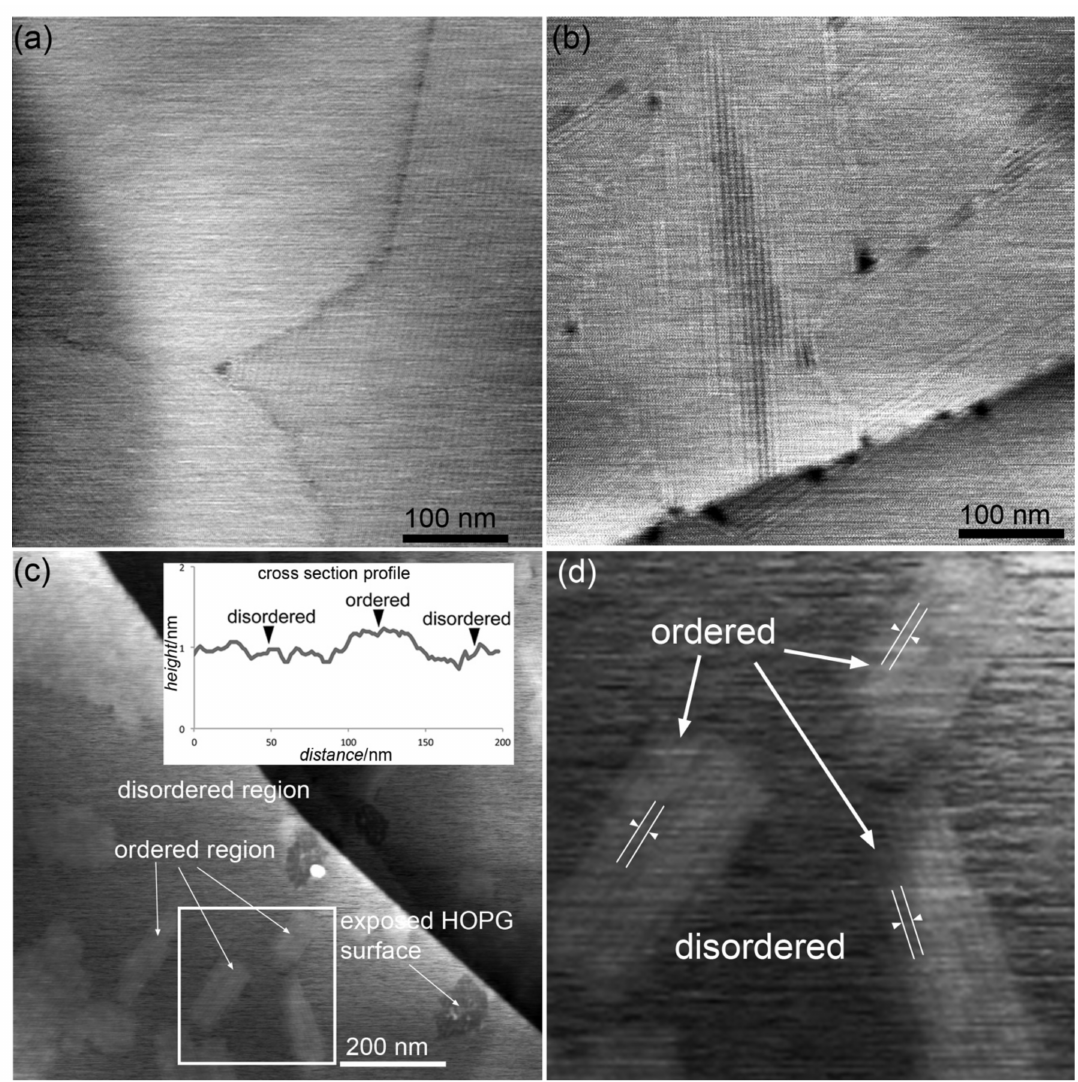
Figure 6. ( a ) AFM image of a PCDYol monomolecular film prepared by spin-coating. Three H arrangement domains cover the entire scan area. ( b ) AFM image of the P domains observed after annealing at 70 ◦ C for 600 s. ( c ) AFM image of the film obtained after annealing at 80 ◦ C for 600 s. In the inset, a cross section profile along the line scan in the horizontal direction is shown. ( d ) The enlarged image of the square region indicated in ( c ). On the island surface, the lamellar structure of P arrangement is observed. No regular pattern is seen over the surrounding sea in glass